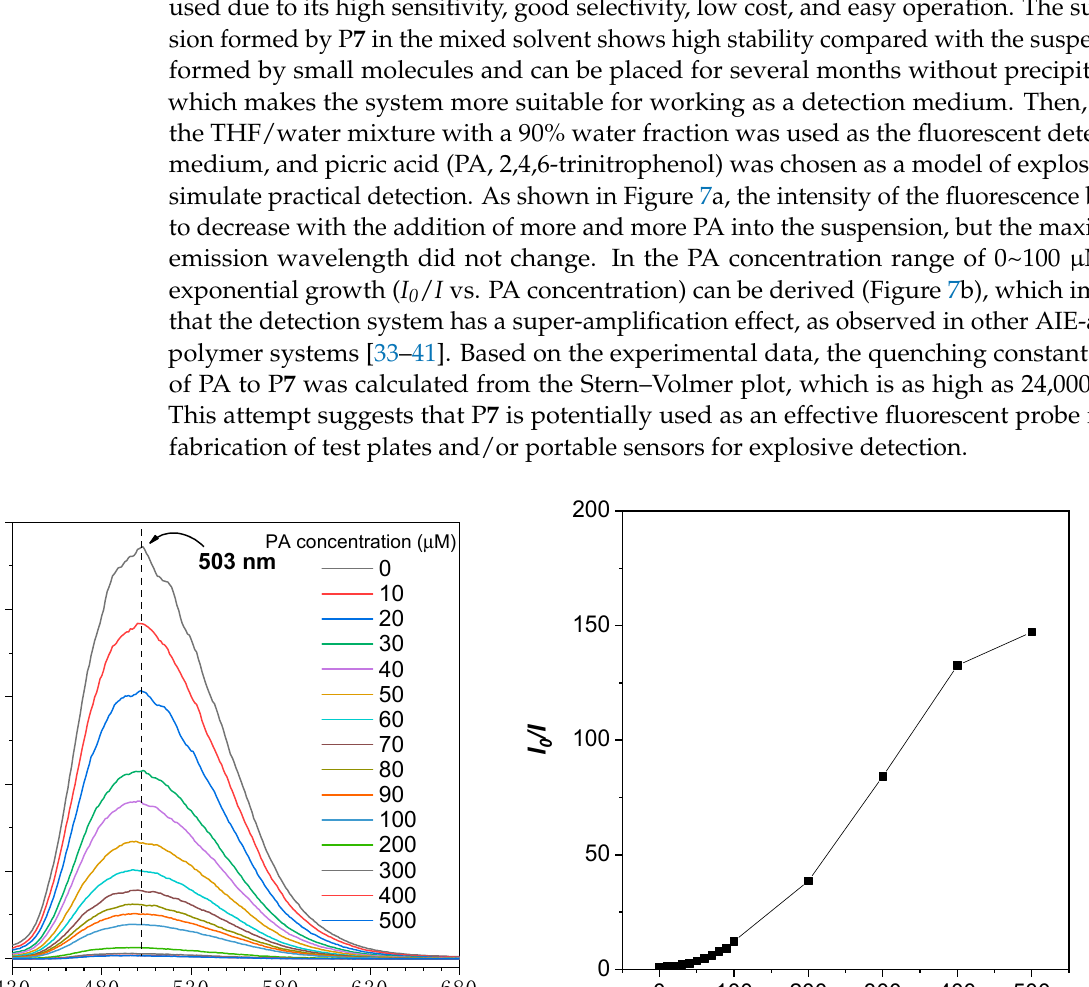
Figure 6. ( a ) PL behavior of P 6 in THF/water mixtures with different water fractions ( f w ). ( b ) Plot of peak intensity of P 6 in THF/water mixtures with different water fractions. I 0 = Peak intensity of P 6 when f w = 0. I = Peak intensity of P 6 when f w = 0. λ ex = 375 nm, Concentration = 100 μ M. Inset: Pho- tographs of the fluorescence of P 6 in THF/water mixtures with a 90% water fraction.